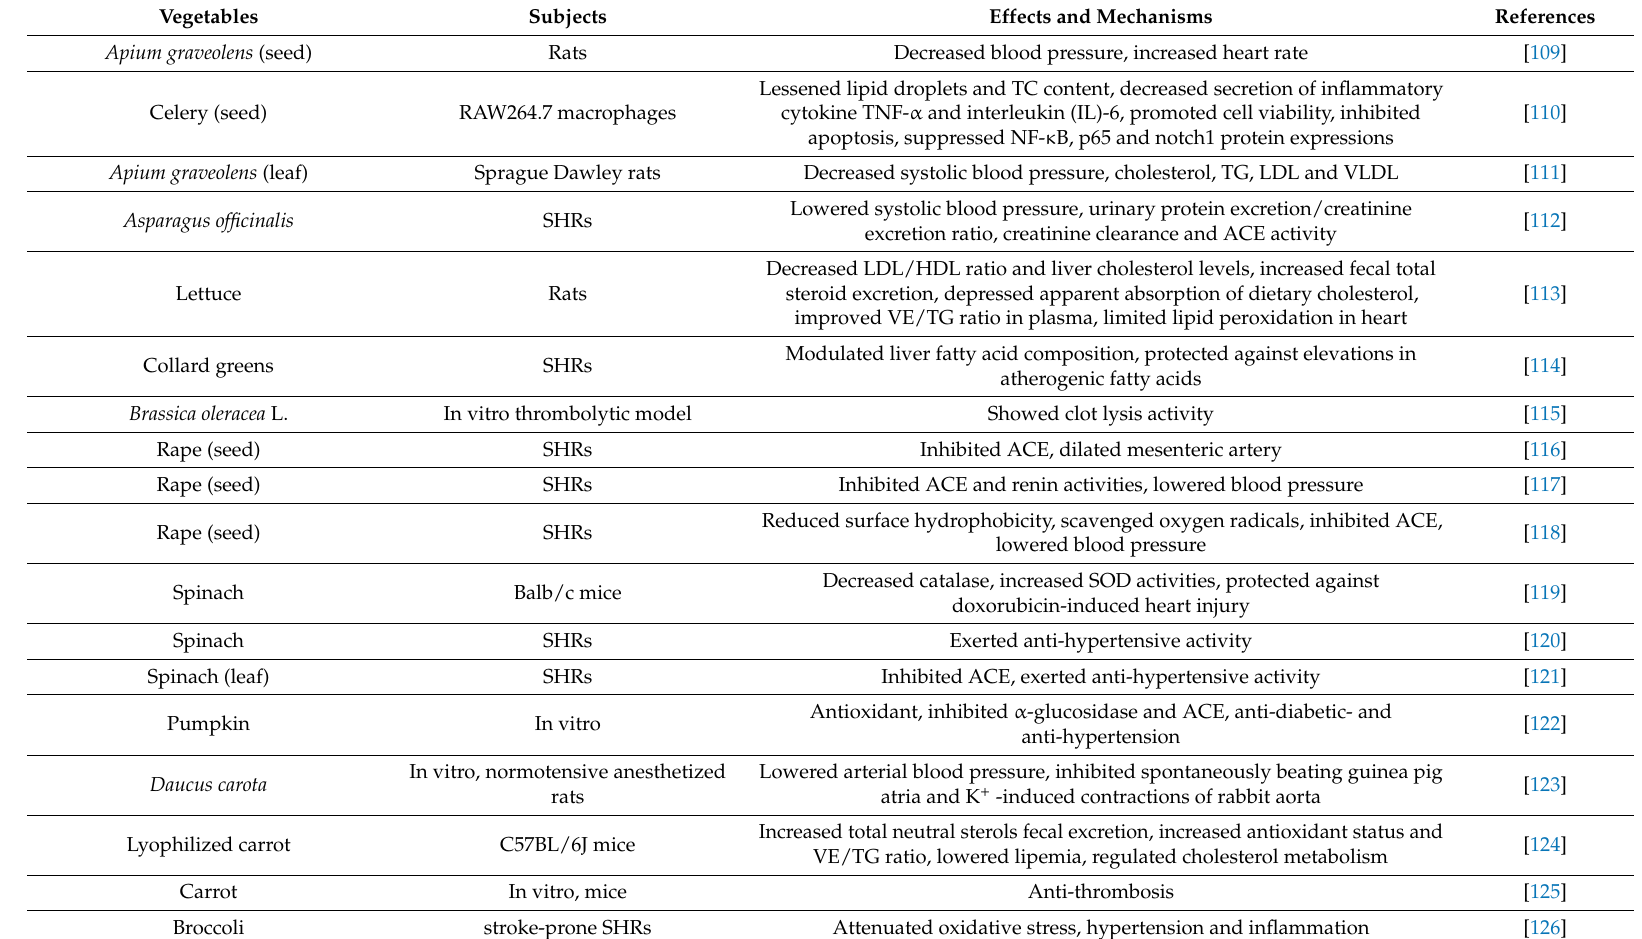
Table 2. Other vegetables and their effects on